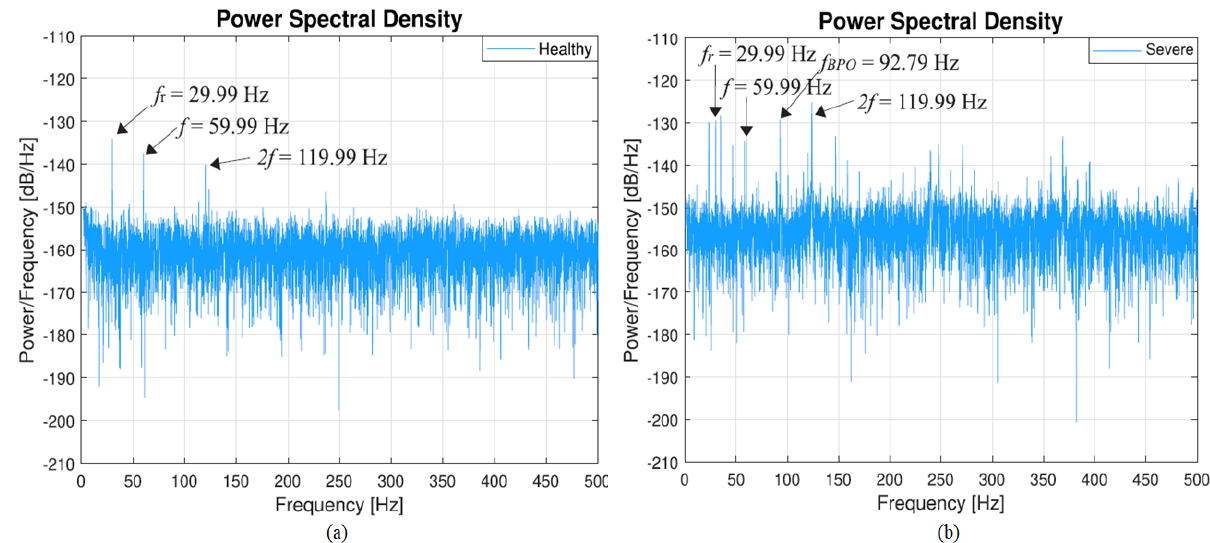
Figure 57. Power spectral density PSD of dynamic strain signal for ( a ) healthy bearings and ( b ) outer raceway faults. Reproduced with permission of [143].